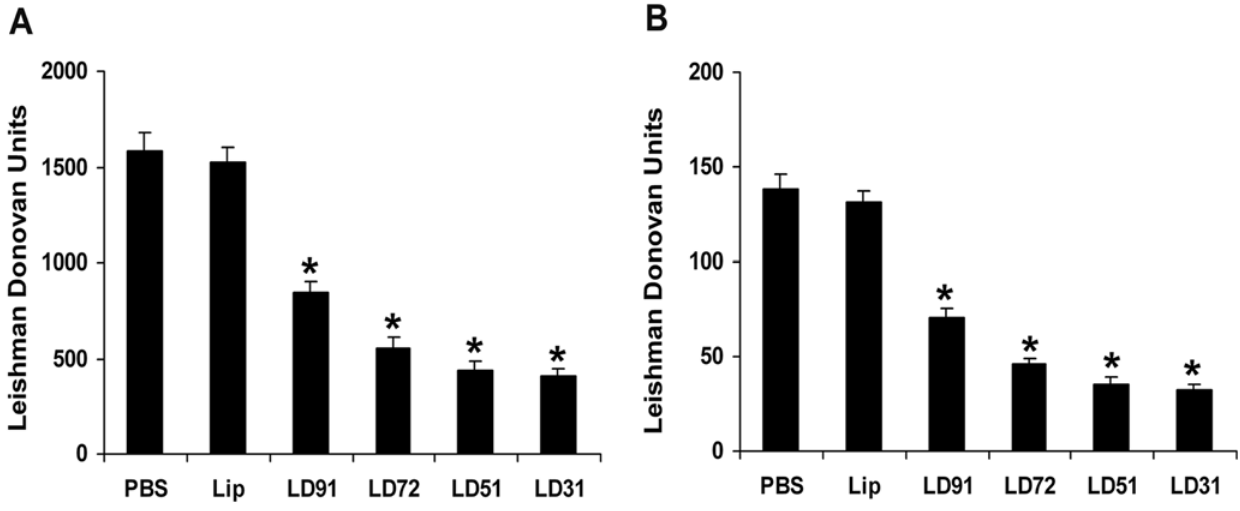
Figure 2. Parasite burdens in BALB/c mice vaccinated with cationic liposomal antigens after L.donovani challenge infection. Mice were vaccinated intraperitoneally 3 times with 2.5 m g of each antigen entrapped in cationic liposomes at 2-week intervals. Control groups received PBS or empty liposomes (Lip). At 10 days after the last immunization, the mice were challenged intravenously with 2.5 6 10 7 promastigotes of L. donovani. Liver (A) and spleen (B) parasite burden were measured 3 months after challenge as Leishman Donovan Units (LDU). The results are mean LDU 6 S.E. of five individual mice per group, representative of two independent experiments with similar results. * p , 0.001 in comparison to control groups as assessed by one-way ANOVA and Tukey’s multiple comparison test.